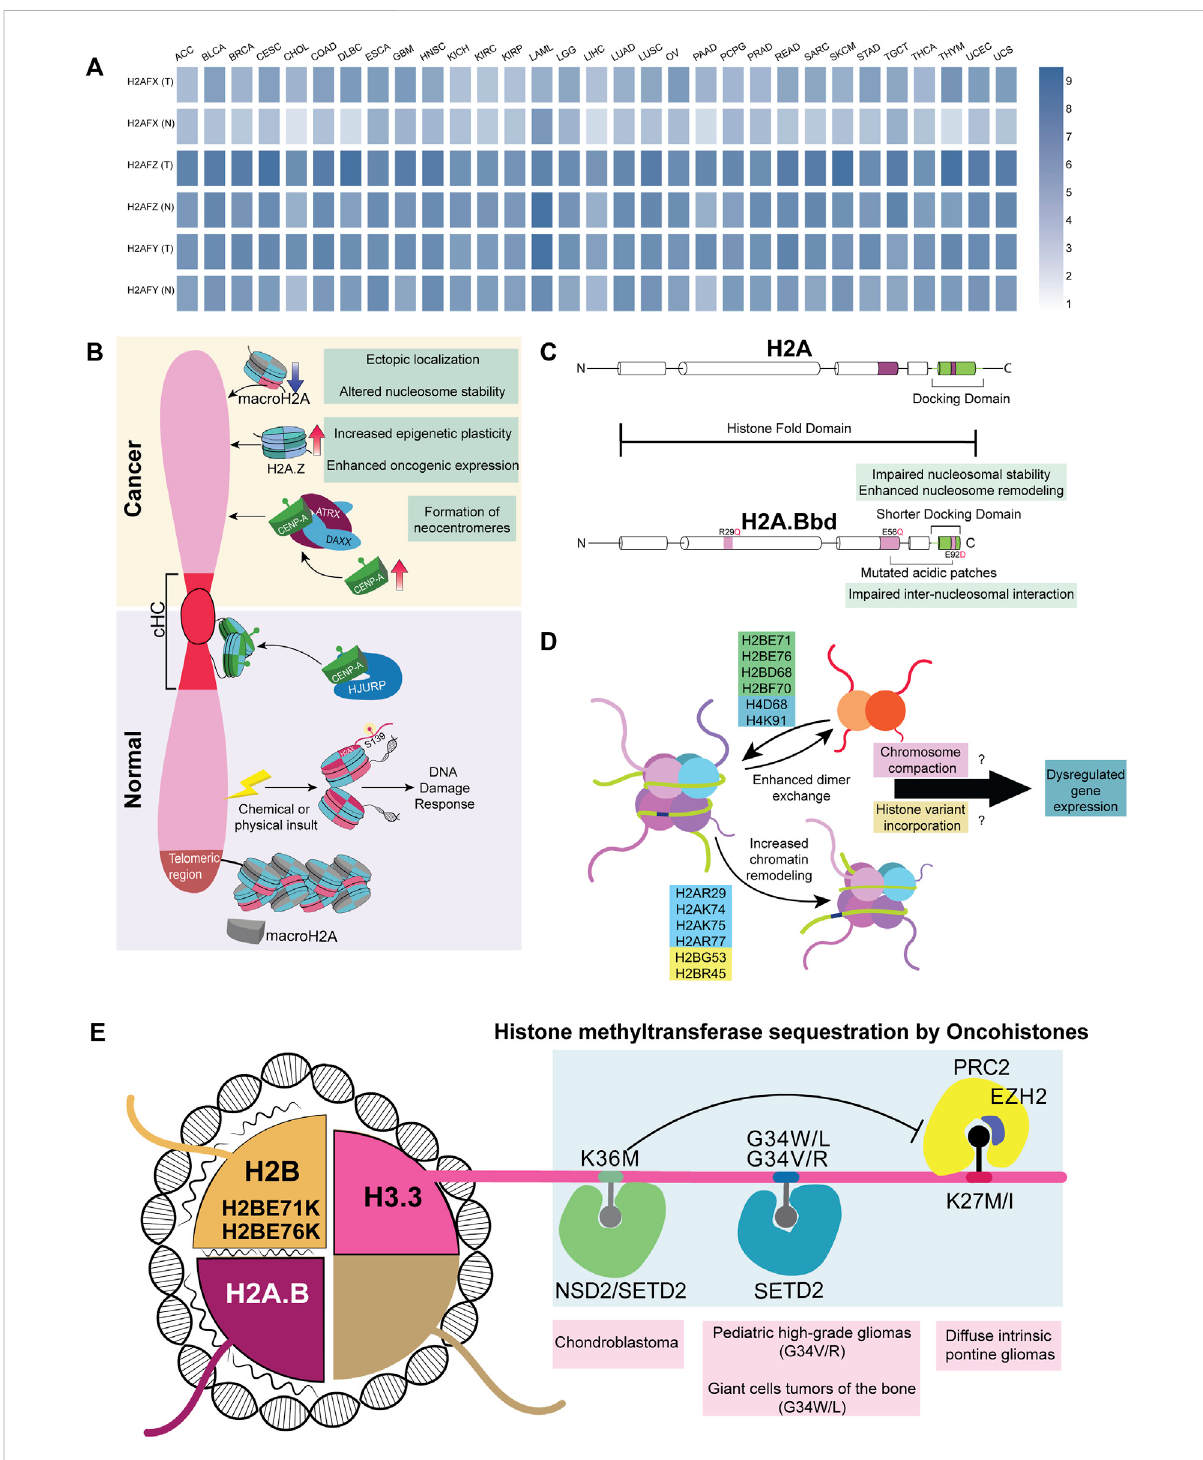
FIGURE 4 Histone variants and mutants in cancer (A) A heatmap representing various non-canonical histones across 31 different cancers; data curated from GEPIA2. Genes H2AFX, H2AFZ, and H2AFY code for H2A.X, H2A.Z.1, and macroH2A, respectively (B) Difference in the recruitment of non- canonical histones in normal versus cancer cells. cHC — Constitutive heterochromatin (C) Comparison between canonical H2A and non-canonical histone H2A.B (D) Mutations in the globular domain of core histones (H2B, H2A, and H4) to enhance dimer exchange and chromatin remodeling.Thisfurtherdysregulatestheexpressionofgenesinvolvedindifferentiation (E) Oncohistones,mutationsinthetailandglobulardomains are found in different cancers. Tail domain mutations sequester histone methyltransferases, while globular domain mutants destabilize the nucleosome, altering the expression of various